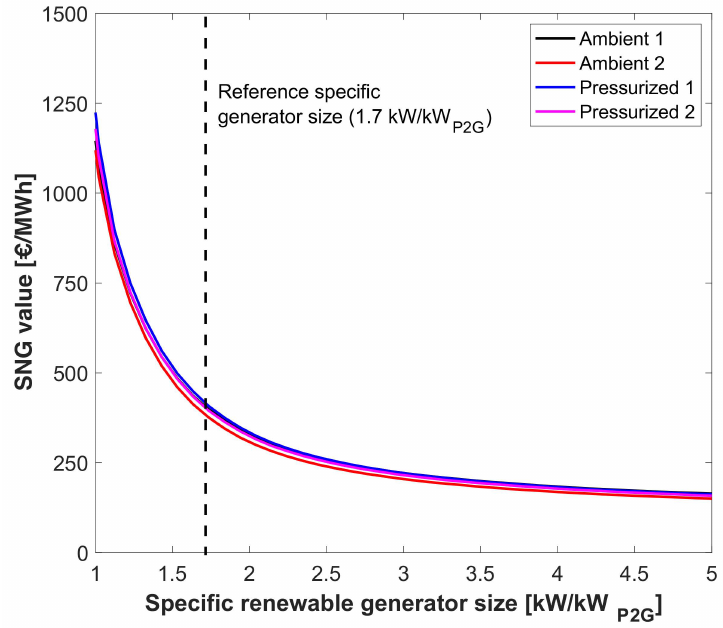
Figure 10. SNG value as a function of the specific wind generator size.